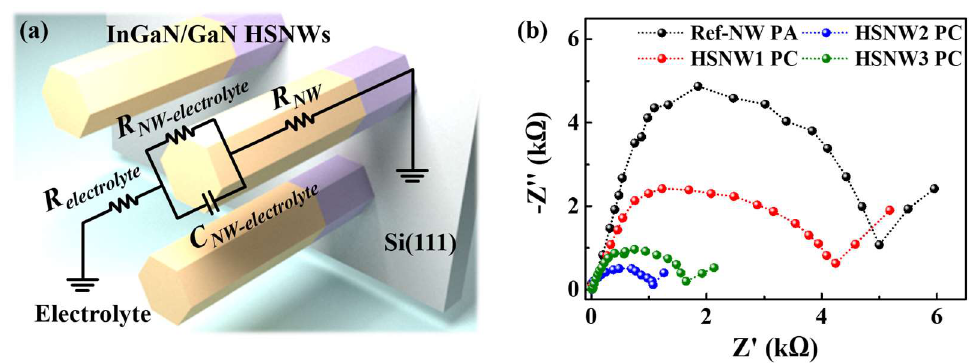
Figure 5. ( a ) Schematic and simplified equivalent circuit of an InGaN/GaN-HSNW PC. ( b ) Nyquist plots of the Ref-NW PA and HSNW1, HSNW2, and HSNW3 PCs measured a potential of − 1 V versus RHE under illumination condition.